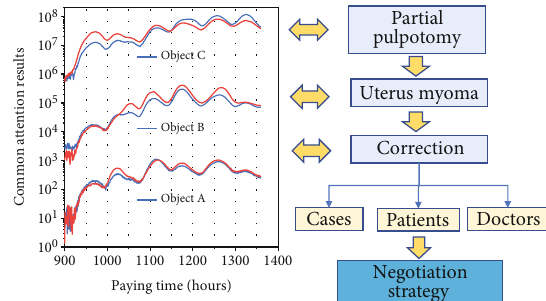
Figure 2: Statistics of common attention